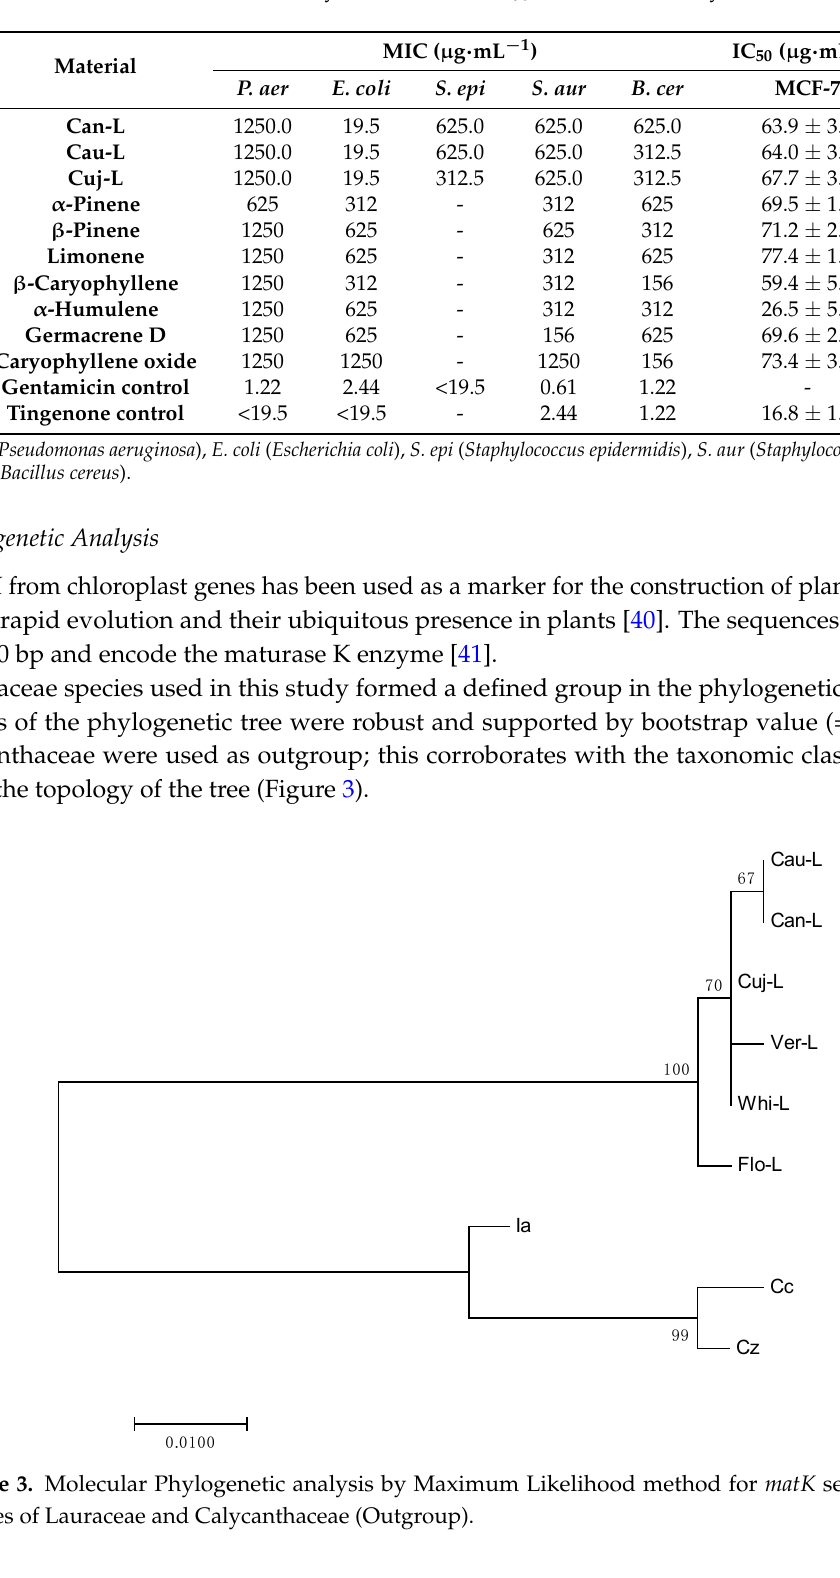
Table 3. Antimicrobial and cytotoxic activities of Ocotea essential oils and some major essential oil components. MIC, minimum inhibitory concentration; IC 50 , median inhibitory concentration.